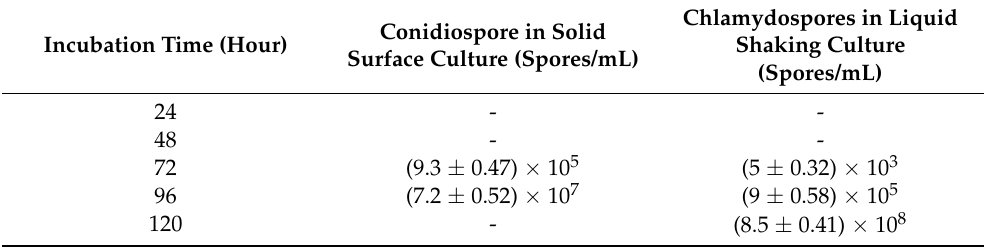
Table 1. Conidiospore and chlamydospore formation of T. asperellum GDFS 1009 in different